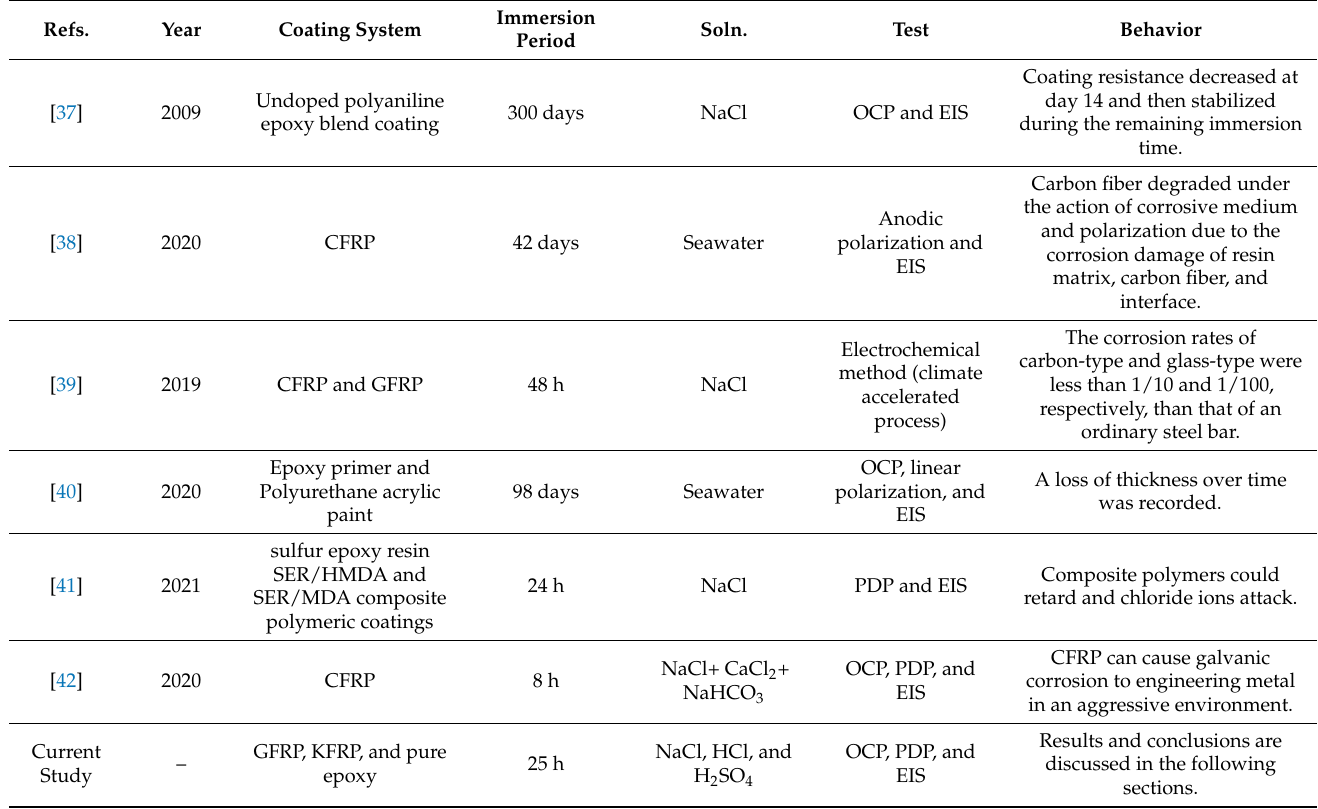
Table 1. Comparison study on the electrochemical behavior of different coating systems for CS. Refs.